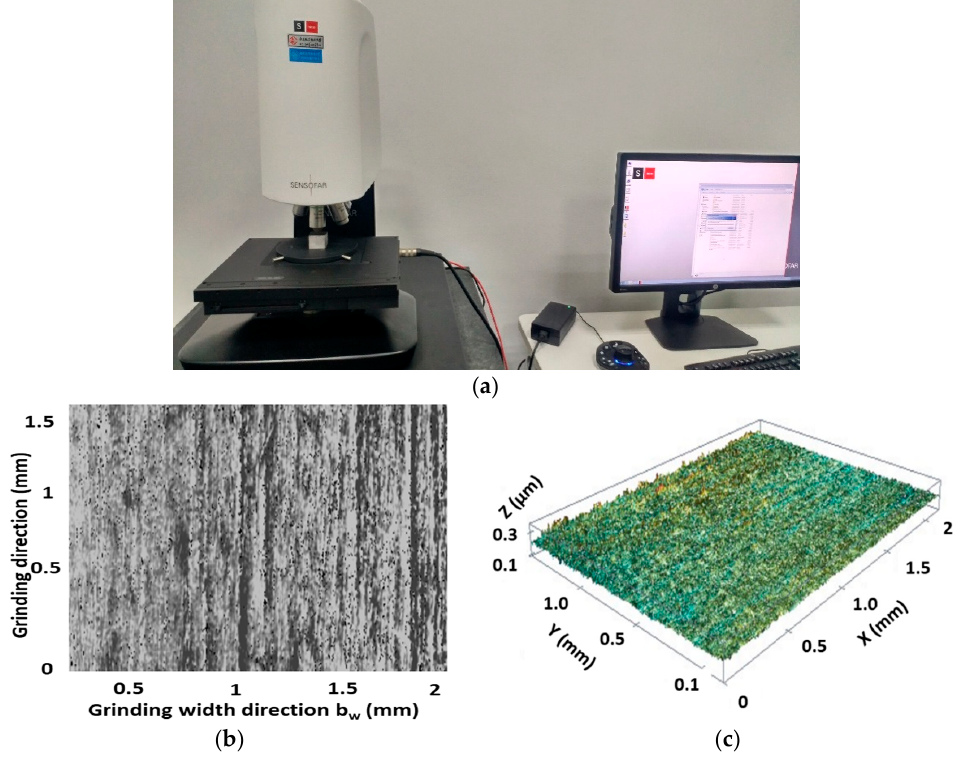
Figure 9. ( a ) General view of 3D optical profilometer S neox (Sensofar, Barcelona, Spain), ( b ) micrography of the ground surface, and ( c ) surface topography of the ground